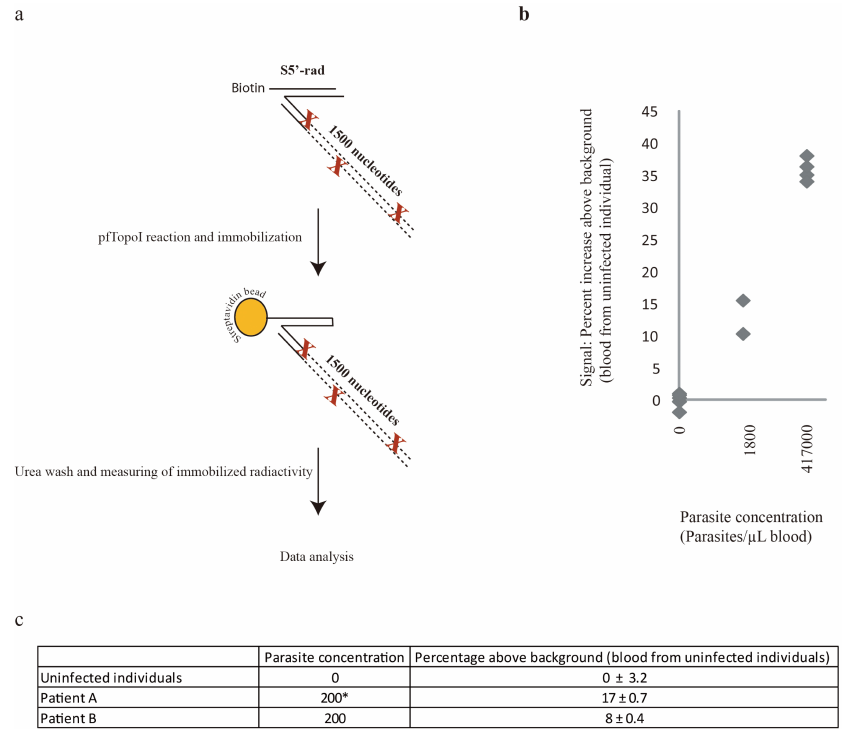
Figure 4. Detection of malaria using the enzyme-based assay in combination with droplet microfluidics-facilitated extraction of active pfTopoI. Extracts from blood with different parasite concentrations were prepared by droplet microfluidics and analyzed using the S5 ' -rad substrate system (shown in ( a ), see text for details). ( b ) The results are shown as percent increase compared to blood samples negative for Plasmodium. The graph shows the results of two independent experiments. The sample with 417,000 parasites pr. μL blood was tested in triplicate in one of the experiments. ( c ) The results from blood samples with low parasite concentrations are shown as percent increase compared to blood samples negative for Plasmodium. * Sample adjusted to 200 parasites/μL blood by dilution of a sample with 400 parasites/μL blood with blood from a healthy individual.